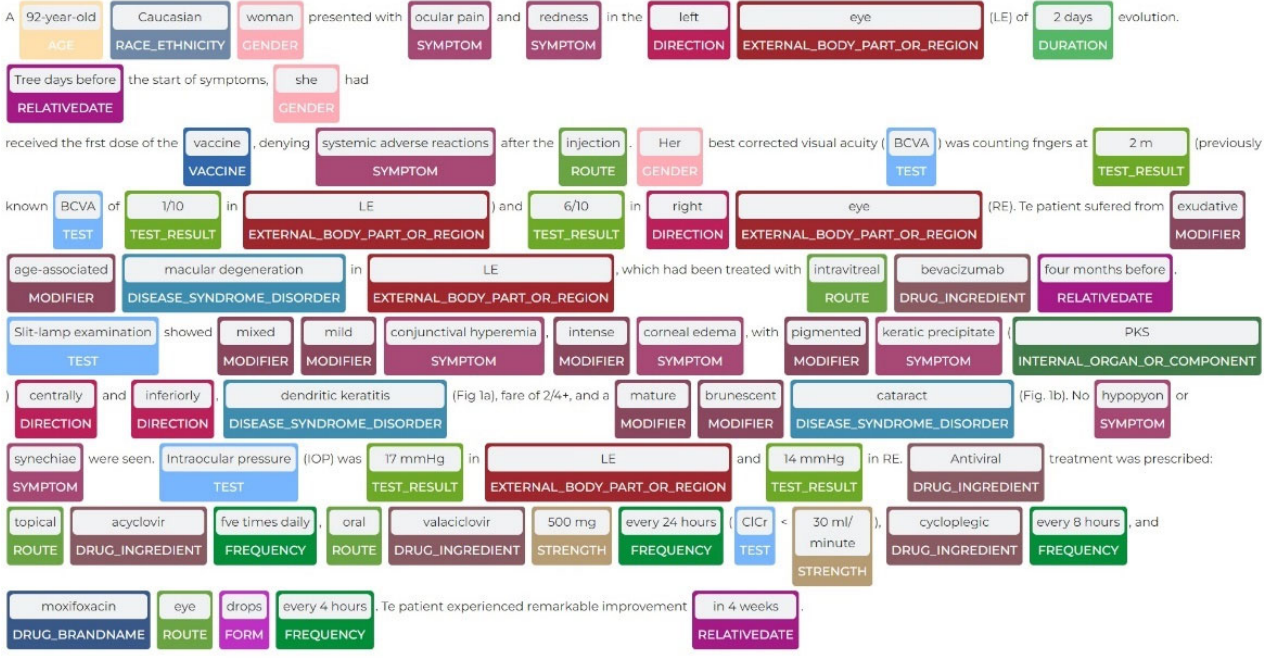
Figure 5. Biomedical entities recognized by proposed pipeline.